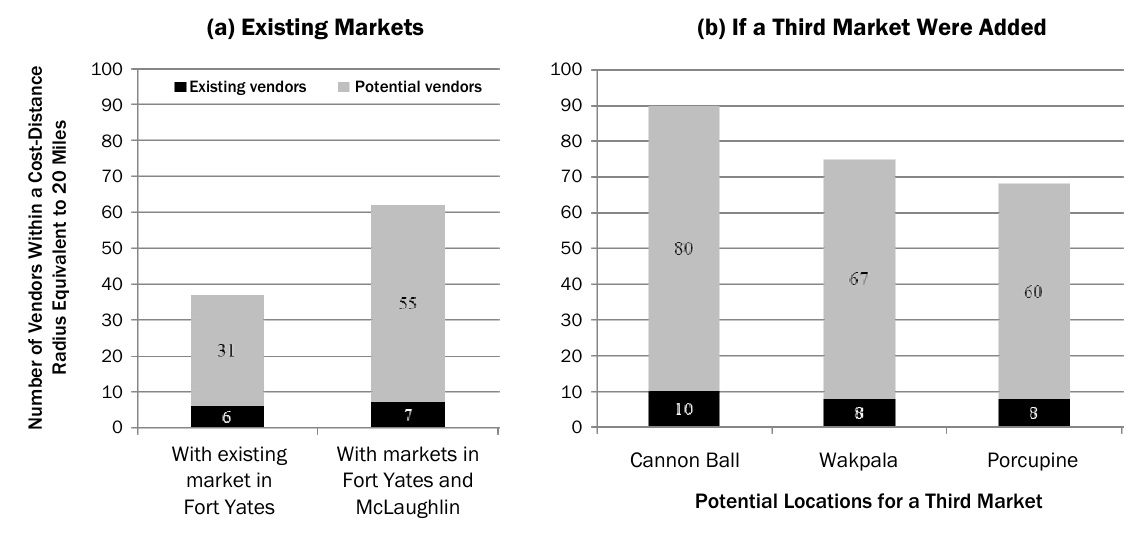
(A) If the existing market in McLaughlin is made permanent, the number of potential vendors within a cost- distance radius of 20 would increase substantially. (B) A market in Cannon Ball would yield the greatest increase if a single third market were